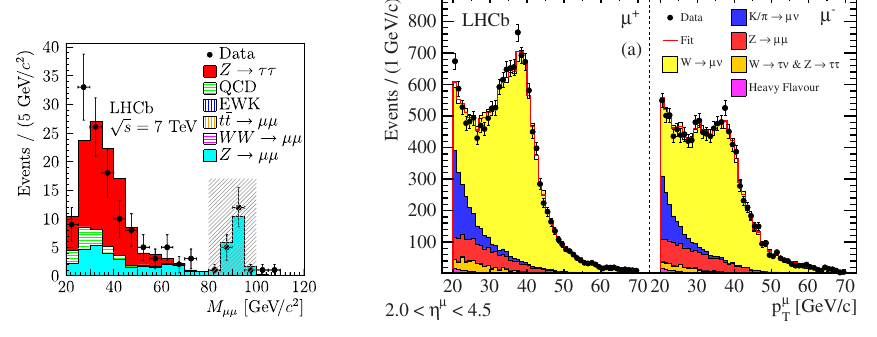
Figure 2. Di-muon invariant mass distribution for the Z → (cid:4)(cid:4) → (cid:2)(cid:2) ν (cid:2) ν (cid:2) ν (cid:4) ν (cid:4) final state (left). Muon transverse momentum distribution of W → (cid:2) ν (cid:2) candidate events